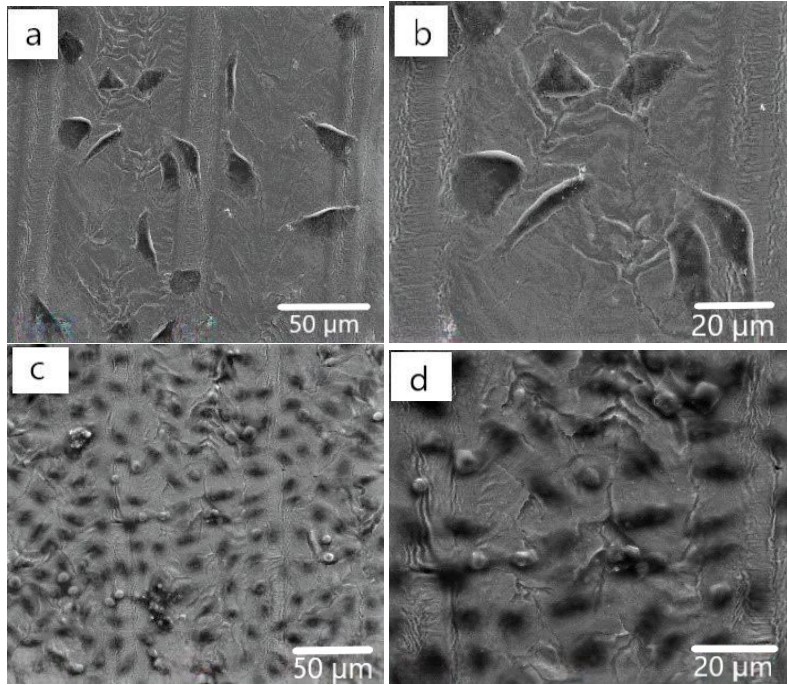
Figure 8. SEM images taken from laser machined 316L investment casting specimen after growth